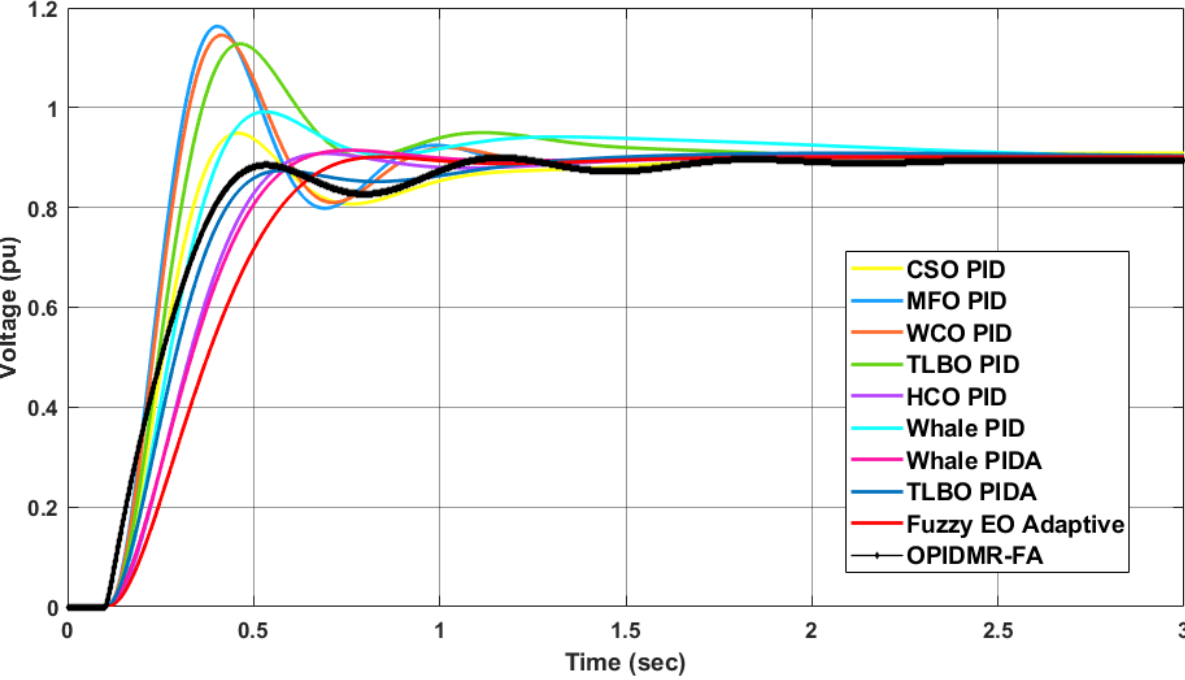
Figure 12. Magnified view of Figure 11. 4.4. Case Study 4 In this case, a dynamic change in the voltage reference was used. Figures 13 and 14 demonstrate the transient responses of all controllers in this case. These results show that the proposed OPIDMR-FA controller succeeded in tracking the first step-change with an average speed between the other controllers, while during